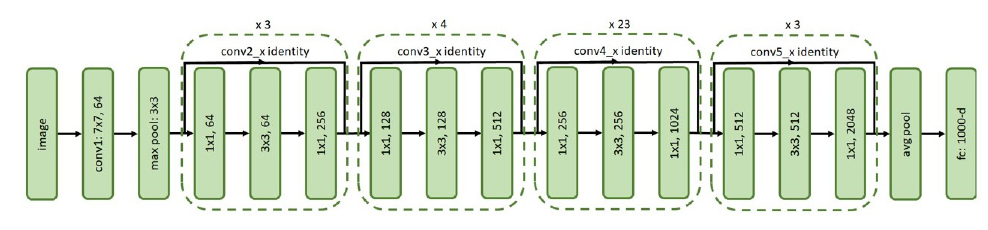
Figure 9. Network architecture of ResNet50.